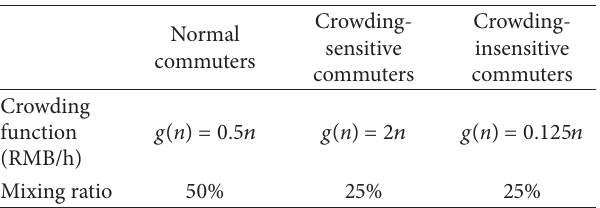
Table 1: Different commuter groups’ crowding functions and mixing